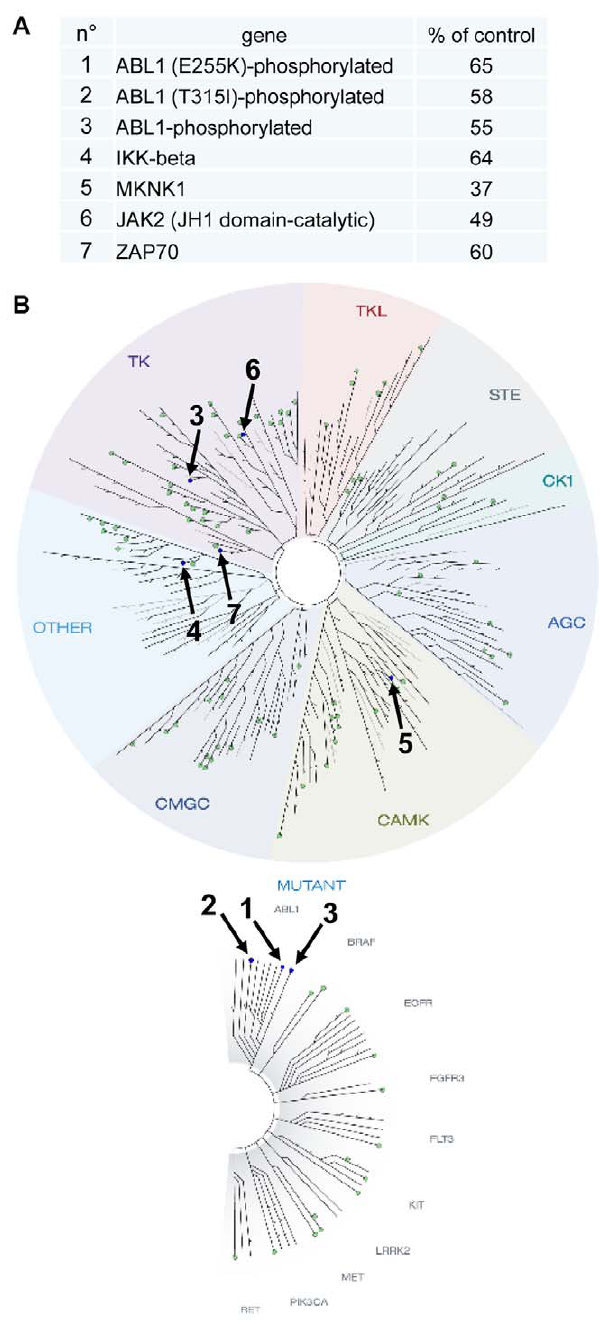
Figure 5. Small molecule kinase interaction map for Triflorcas. Compound was screened against a KINOME scan (http://www. kinomescan.com) panel of 98 kinases. (A) The table indicates the kinases for which Triflorcas reduced more than 30% the binding constant. The ligand binding for each kinase (% of control condition) is indicated. (B) TREEspot image of the 98 kinases screened with the position of Triflorcas targets: Abl wild-type, Abl E255K and Abl T315I mutant forms, IKK-beta, JAK2, MKNK1, and ZAP70. The complete dataset is shown in Table S2. TK: tyrosine kinase; TKL: tyrosine kinase like; STE: STE kinase; CK1: cell kinase1; AGC: PKA, PKC, PKG kinases; CAMK: calcium calmodulin-regulated kinase; CMGC: CDK, MAP, GSK, CDK-like kinase.